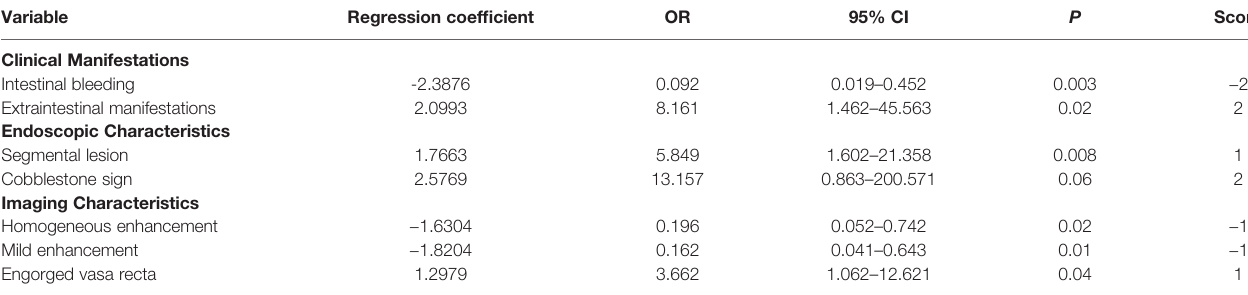
TABLE 6 | Multivariate Analysis and Scores Based on Clinical Manifestations, Endoscopic, and Imaging Characteristics. Variable